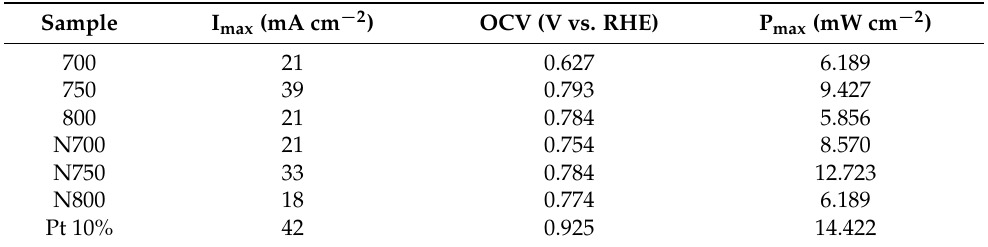
Figure 9. ( a ) Fuel cell polarization and ( b ) power density curves at 30 °C and 100% relative humidity using H 2 and O 2 gases. Table 7. Fuel cell parameters for electrocatalysts tested at 30 °C and 100% relative humidity using H 2 and O 2 gases.